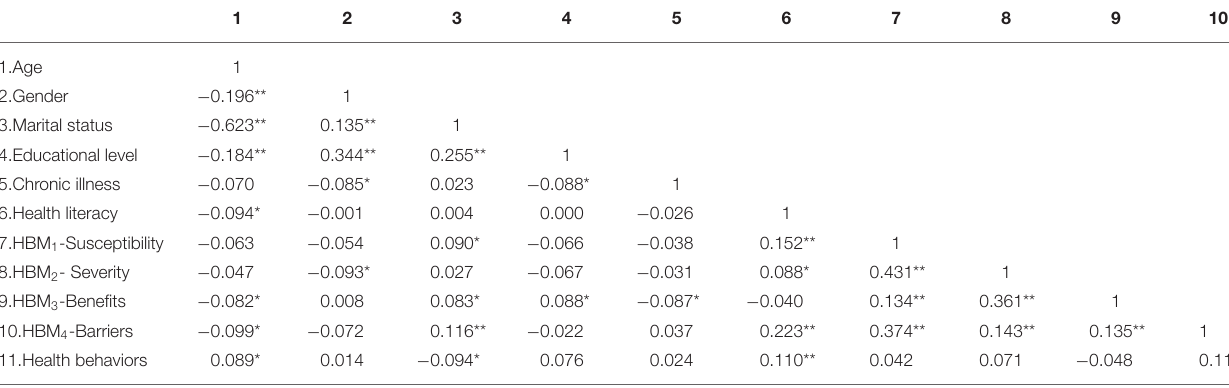
TABLE 3 | The correlation matrix between health behaviors, health literacy and health beliefs.